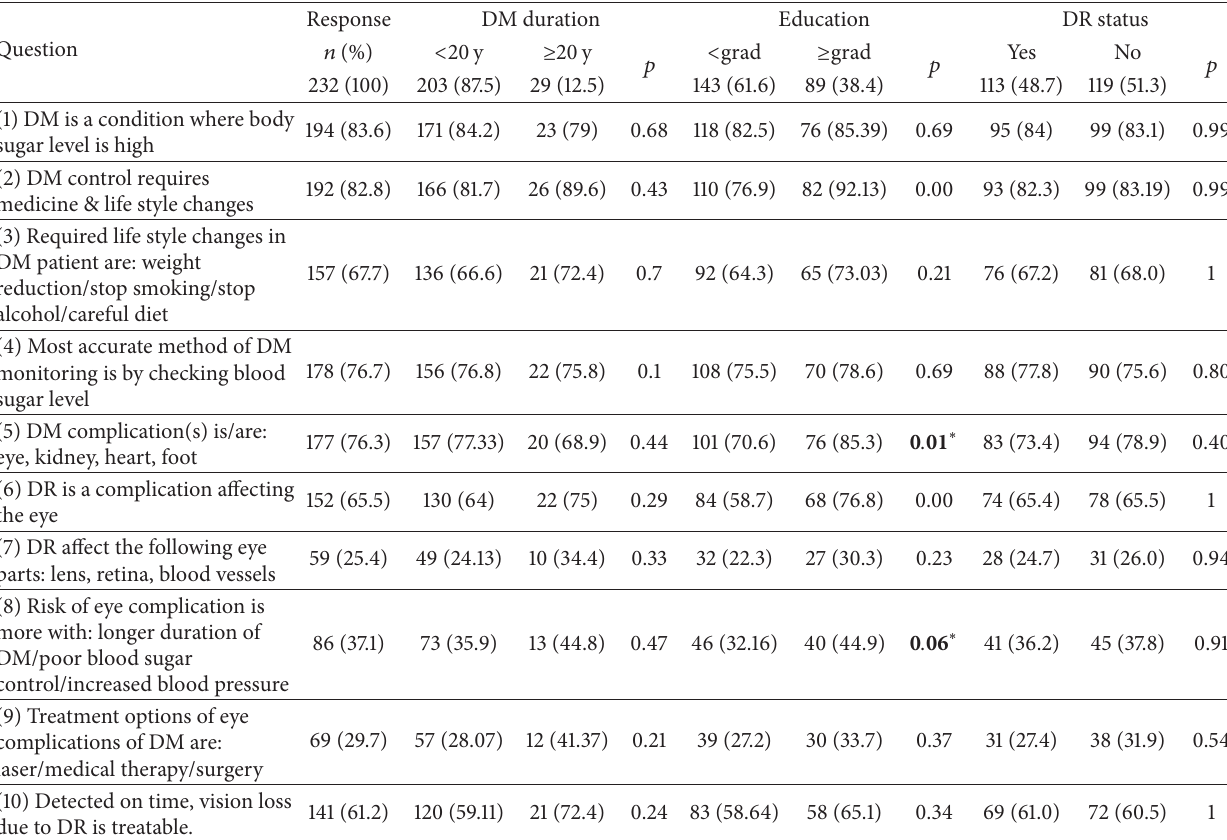
Table 2: Patient response and subgroup analysis of knowledge questions.